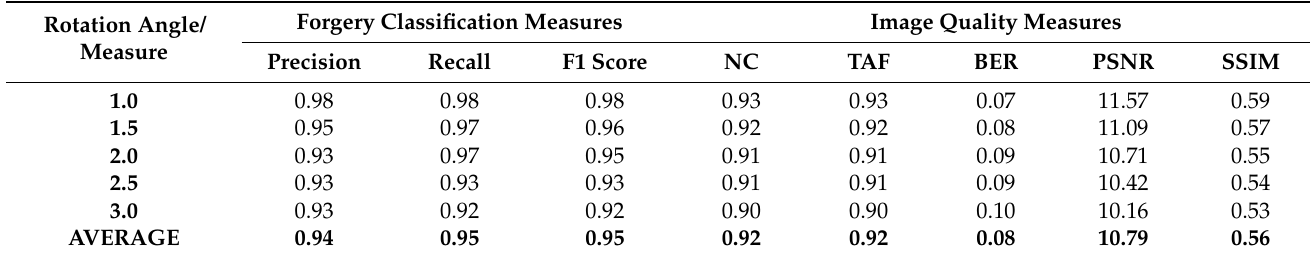
Table 5. Forgery classification and image quality measure values for the second group of experiments (Rotation